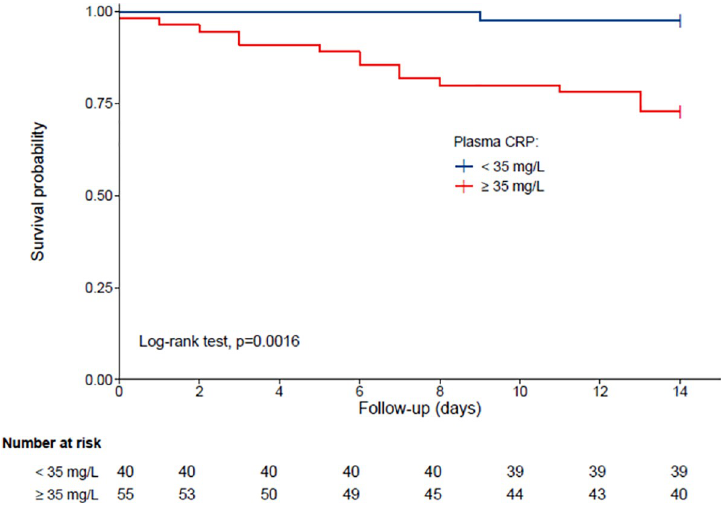
Fig 1. Kaplan-Meier estimates of the cumulative probability of COVID-19 participants’ survival according to plasma CRP (n = 95). Group 1: plasma CRP < 35 mg/L; Group 2: plasma CRP � 35 mg/L.